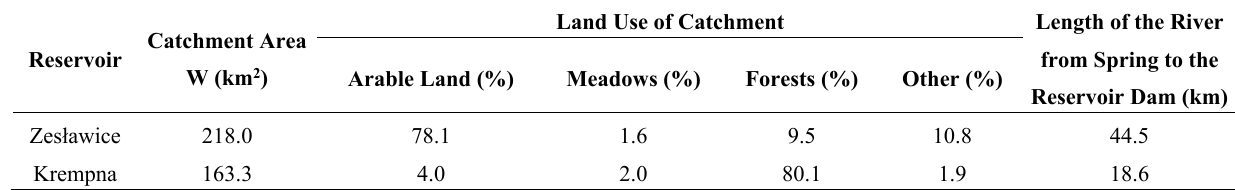
Table 1. The selected basic parameters of the catchments.